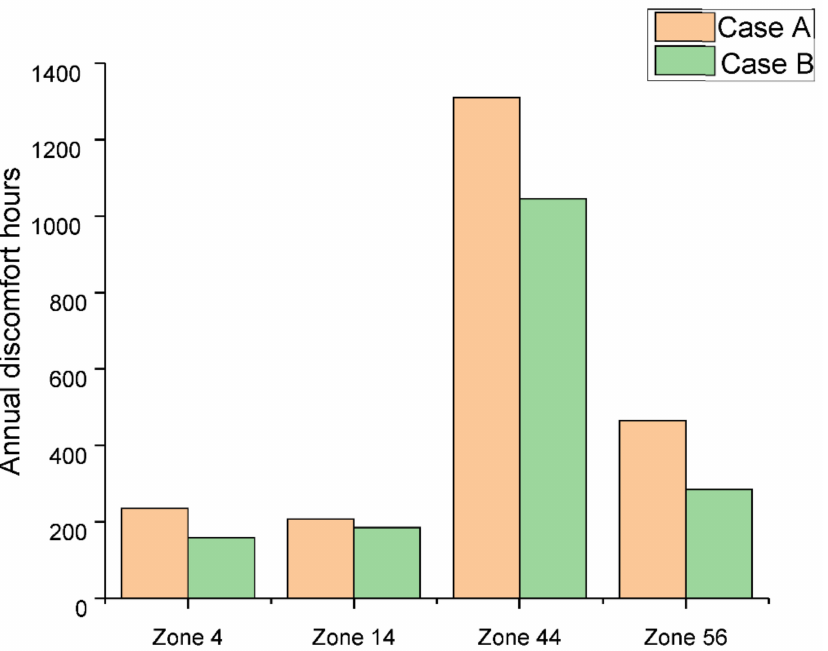
Figure 25. Comparison of number of annual discomfort hours during occupancy time in case A (no low-E film) and case B (with low-E film) based on EN 16798-1.